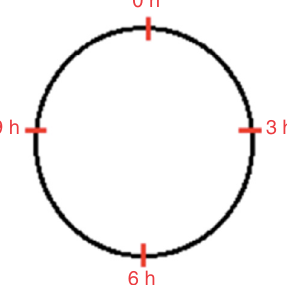
Schematic drawing showing the location of growth factor injection in the epithelial and mixed wounds in the four quadrants: three, six, nine, and 12